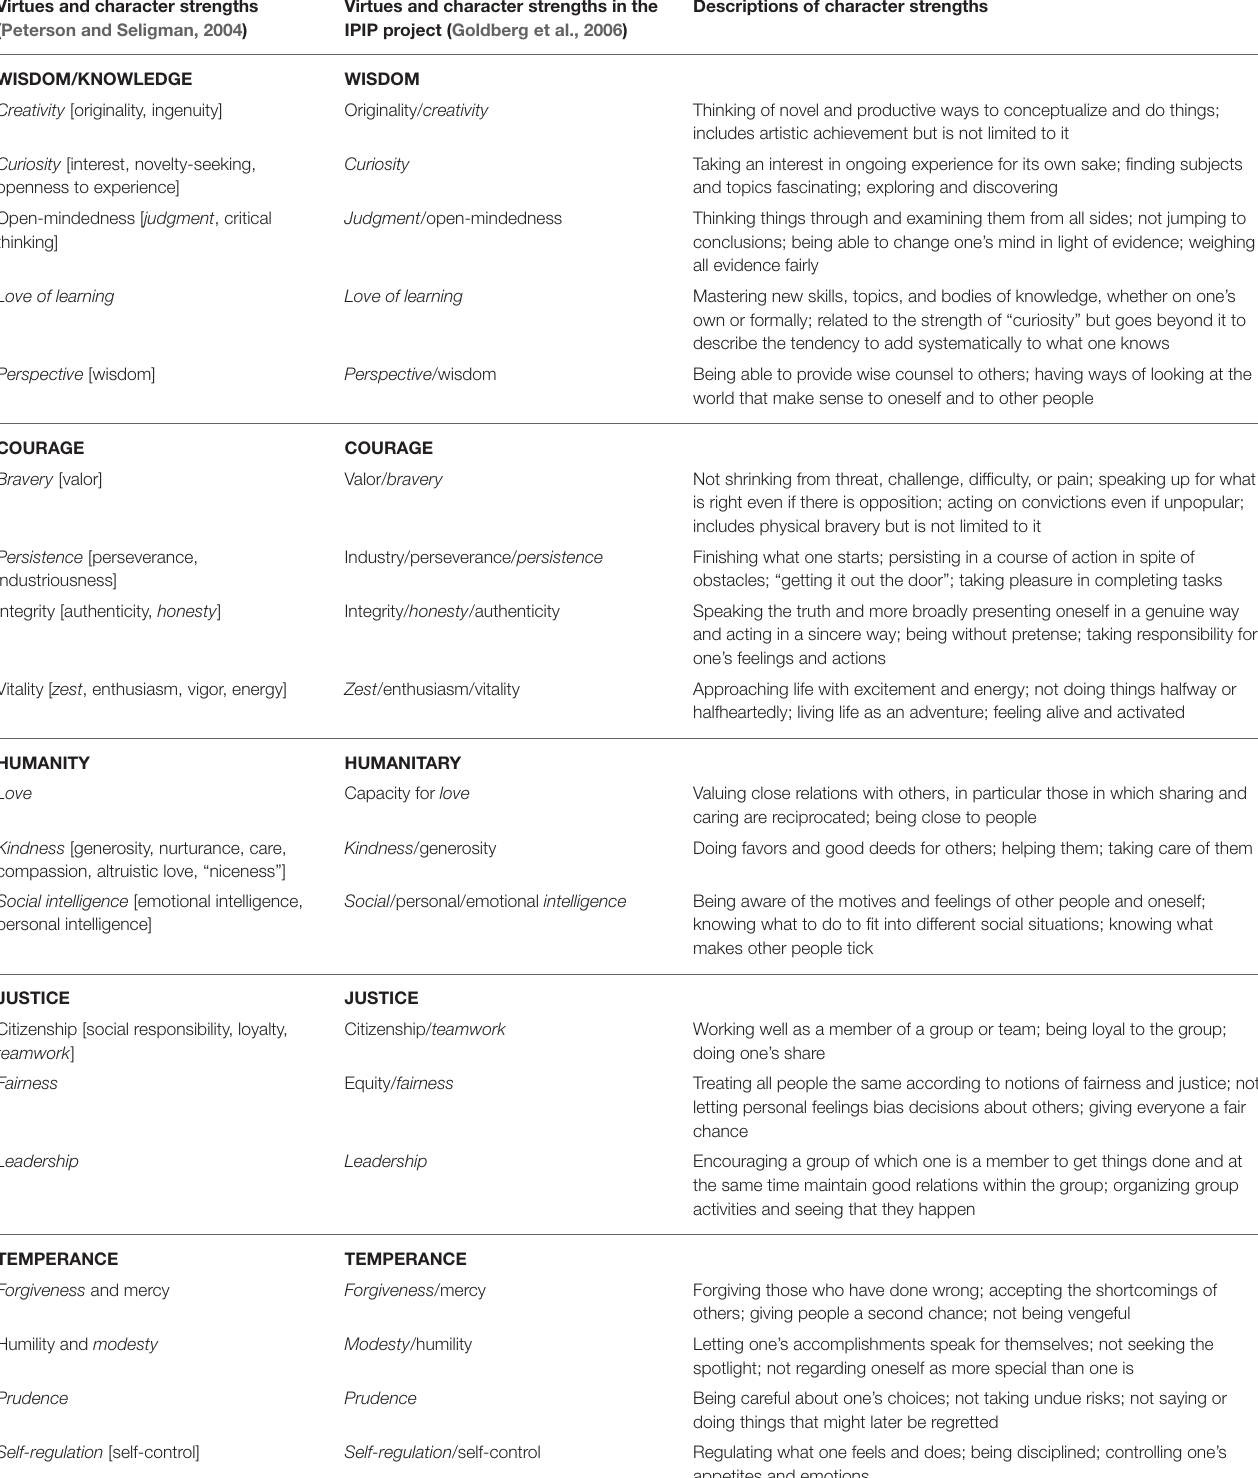
TABLE 1 | Lists of virtues, their corresponding character strengths (Peterson and Seligman, 2004; Goldberg et al., 2006, IPIP project), and short descriptions of the character strengths (Park and Peterson, 2010, pp. 540–541). Virtues and character strengths (Peterson and Seligman,